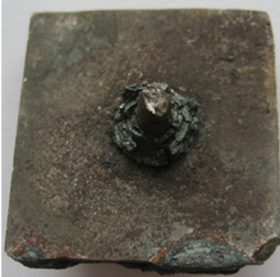
Figure 15. Photo of the Ni3Al intermetal sample after exposure in the boiler combustion